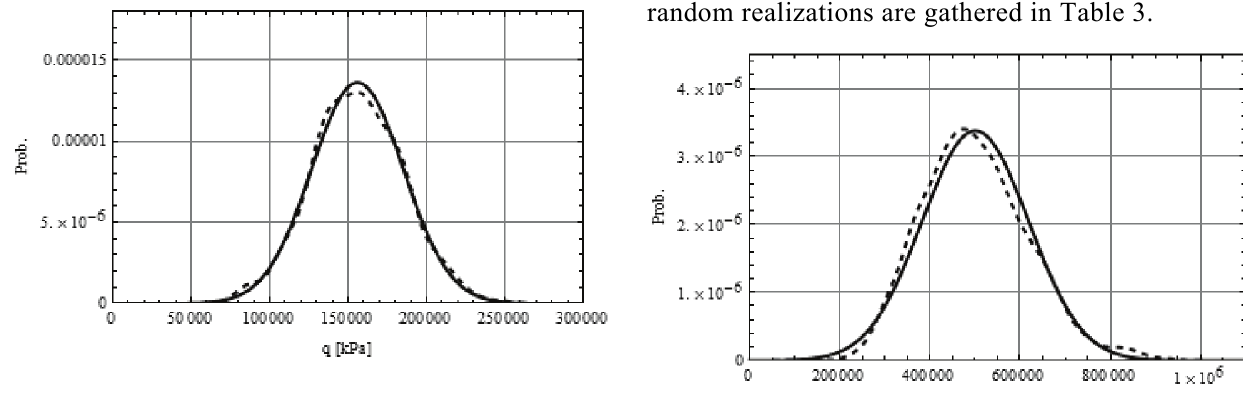
Fig. 5. Agreement between continuous histogram function obtained from analysis (black line) and probability density function for respective normal distribution (dotted line),  = 1.0 m Fig. 6. Agreement between smooth histogram